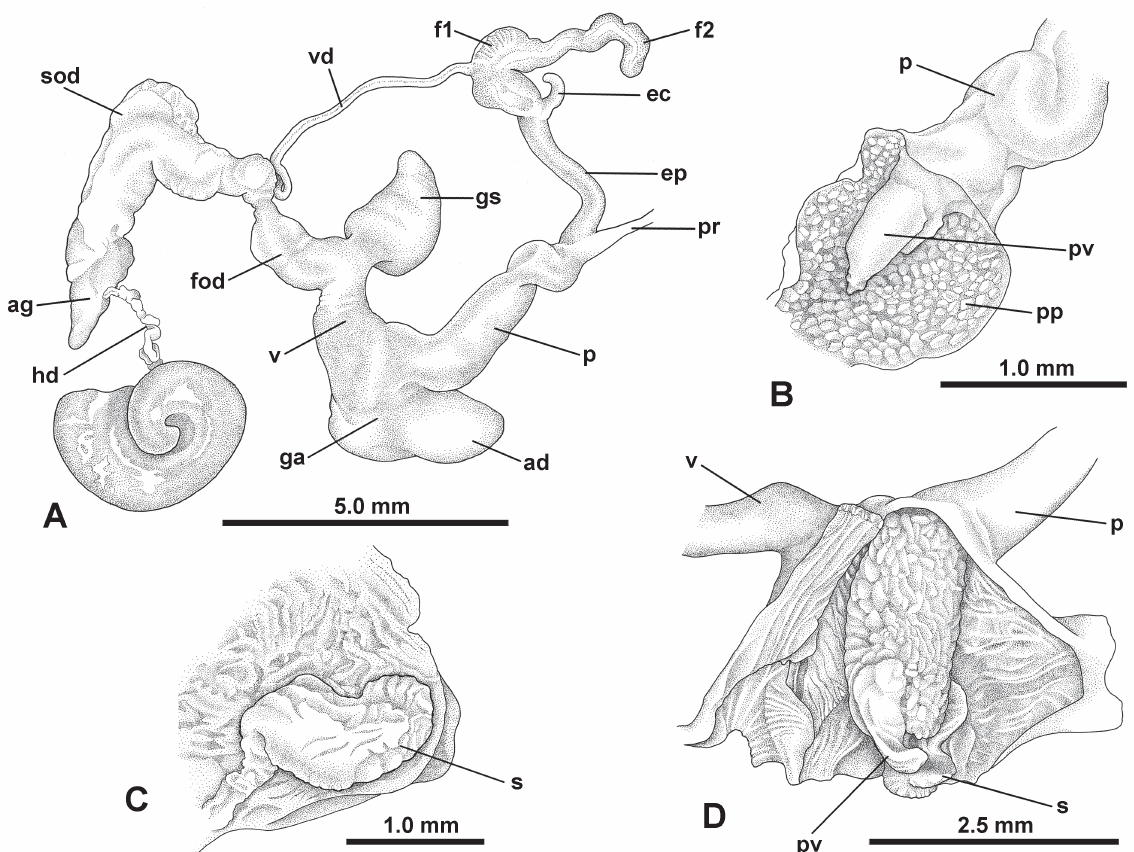
Fig. 16. Sheldonia wolkbergensis sp. nov., genitalia. A . Entire reproductive tract. B . Basal portion of penis opened to show penial verge. C . Atrial diverticulum dissected to show atrial stimulator. D . Partially everted distal genitalia with penis and stimulator protruding into genital atrium. A–C. Holotype (NMSA P0156/T4074). D. Paratype